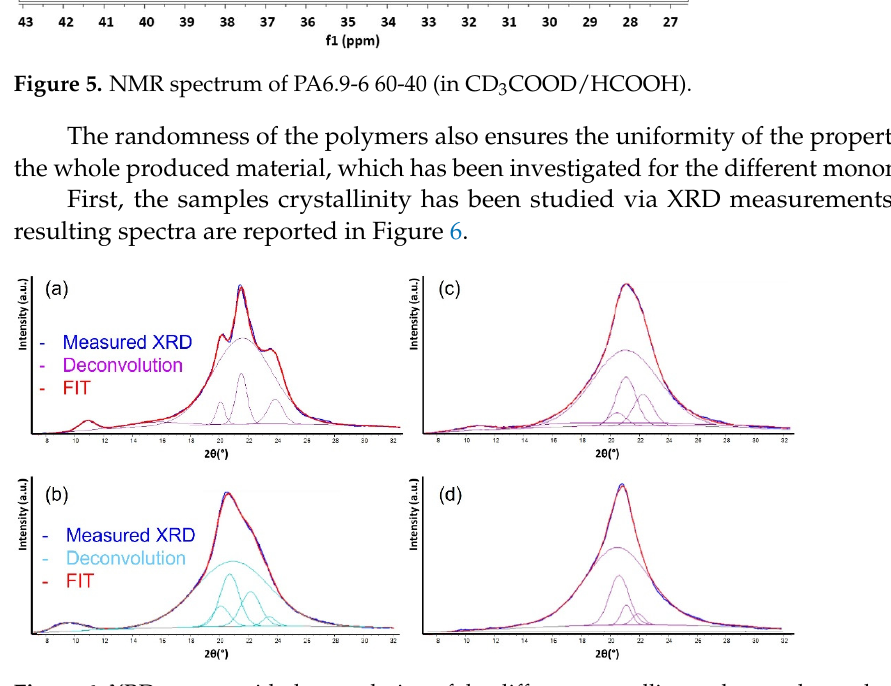
Figure 5. NMR spectrum of PA6.9-6 60-40 (in CD 3 COOD/HCOOH).